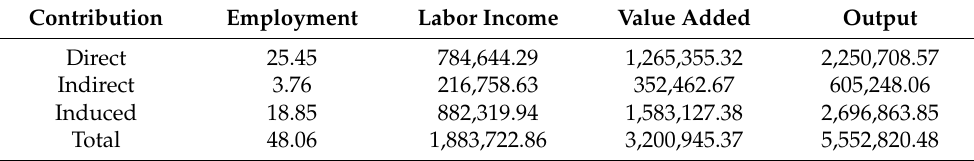
Table A2. Contribution of GTM Spending to Duval, Flagler, and St. Johns Counties (Annual). Contribution